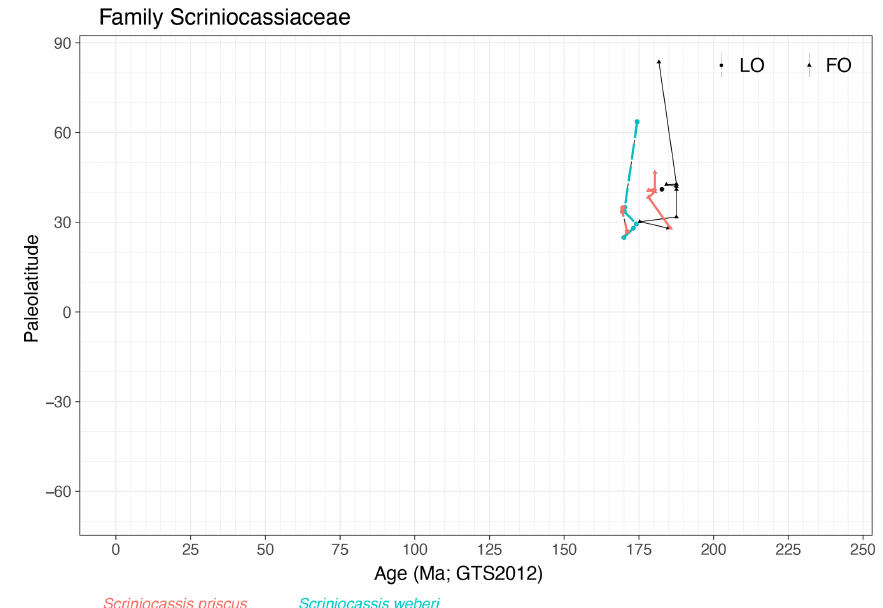
Figure 15. Same as Fig. 5 but for the family Scriniocassiaceae.